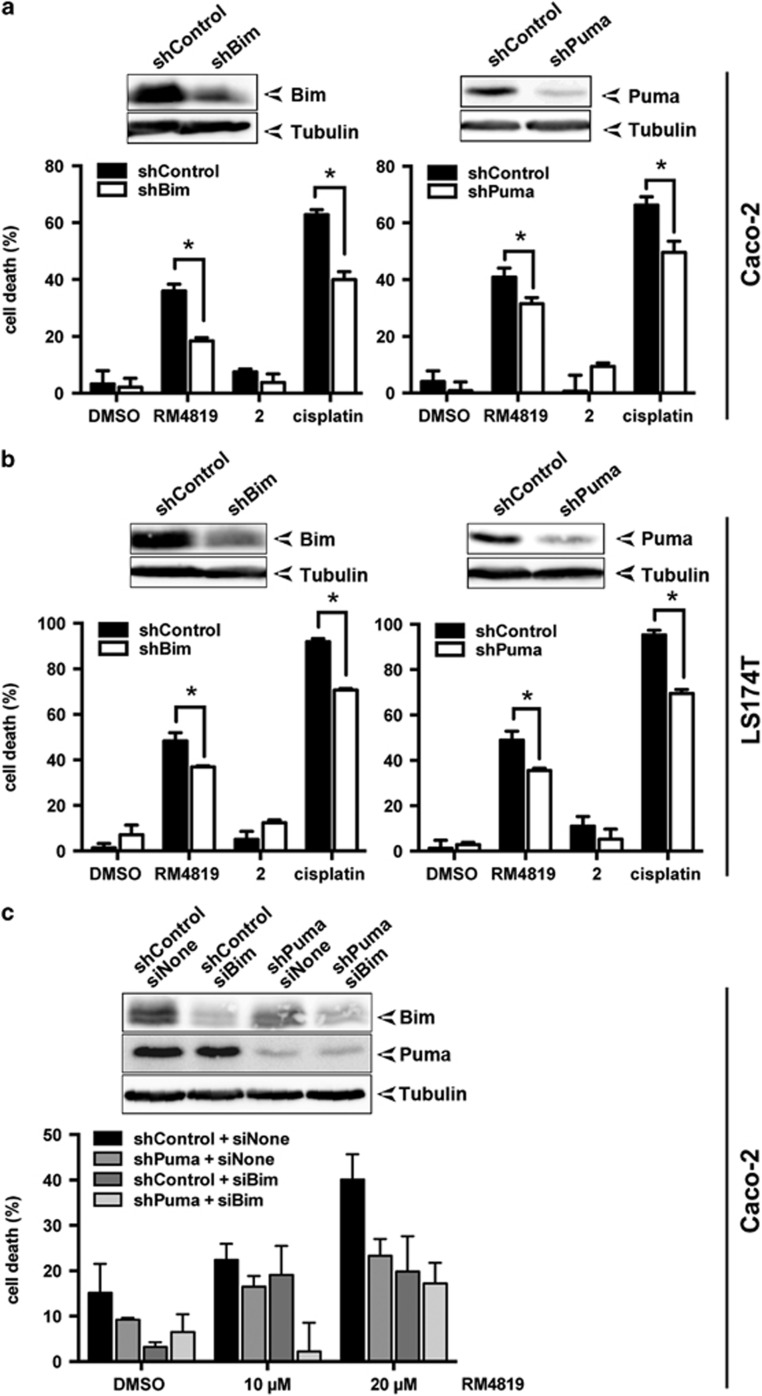
Thiazolide-induced cell death is regulated by Bim and Puma. Caco-2 (a) and LS174T (b) cells were transduced with Bim- or Puma-targeting shRNA (shBim, shPuma) or non-targeting shRNA (shControl). Bim and Puma knockdown efficiency was monitored by western blot (insets). Cells transduced with shControl, shBim, or shPuma were treated with DMSO (0.1%), RM4819 (20 μM), or cisplatin (1 μg/ml) for 40 h. Cell death induction was calculated by an MTT assay. Mean values of triplicates±S.D. of a representative experiment are shown (n>3). *P<0.01 (c) Caco-2 cells transduced with shControl and shPuma were transiently transfection of Bim-targeting small interfering RNA (siBim) or control siRNA (siNone). Silencing of both Bim and Puma was confirmed by western blotting. Cells were treated with 10-20 μM RM4819 or 0.1% DMSO for 40 h. Cell death induction was assessed by an MTT assay. Mean values of triplicates±S.D. of a representative experiment are shown (n>3)